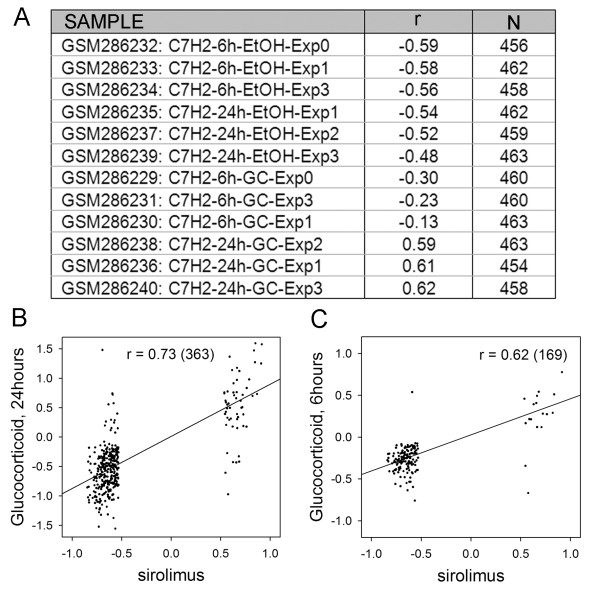
The CMAP rapamycin query score highly against a glucocorticoid treatment experiment. The correlations with the individual samples are shown in A and the regression plots for the pooled treatment and control groups are shown at 24 hours in B and at 6 hours in C.